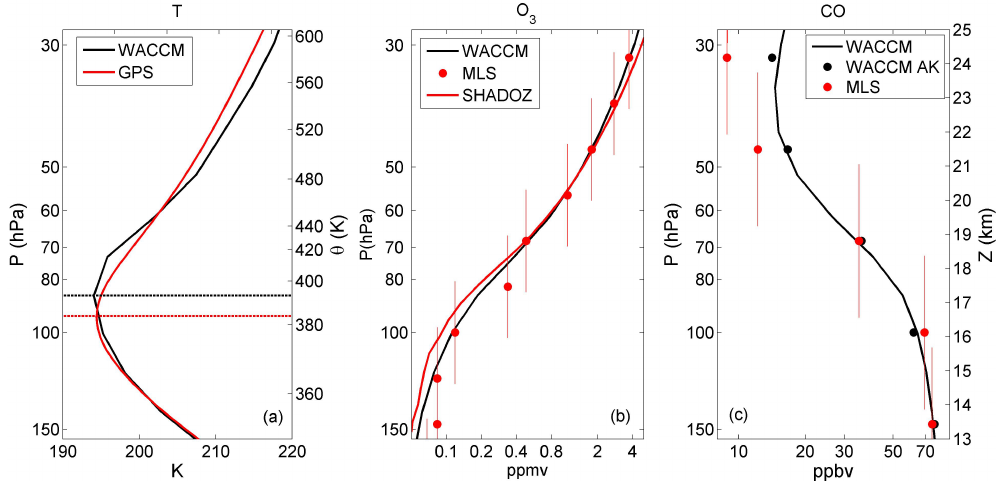
Fig. 1. Vertical structure of annual mean temperature (a) , ozone (b) and CO (c) in WACCM and in observations averaged over the tropics (18 ◦ S–18 ◦ N for WACCM, 18.75 ◦ S–18.75 ◦ N for MLS and 20 ◦ S–20 ◦ N for GPS). Solid black line: WACCM, solid red: GPS in (a) and SHADOZ in (b) , red dots: MLS, black dots in (c) : WACCM with MLS CO averaging kernel. The vertical red bars indicate the width of the MLS averaging layers. For reference, the location of annual mean isentropic levels in WACCM is indicated on panel (a) and the approximate altitude on panel (c) , calculated as Z = − H ln (P/P 0 ) , with P 0 =1000hPa and H =7km. The ozone and CO scales are logarithmic in order to better represent the sharp vertical gradients. Horizontal dashed lines in panel (a) indicate the location of the annual mean cold point tropopause in WACCM (black) and in GPS observations